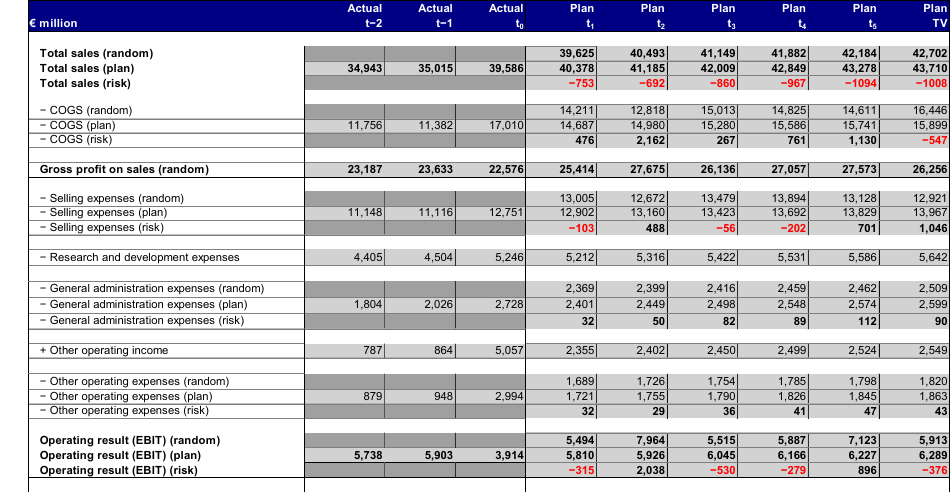
Figure 3. Excerpt of the income statement planning. In step 3, the insolvency risk is linked to the planning model and the insolvency probability is calculated via a heuristic function using the equity ratio and the return on equity employed (ROCE) (see Figure 4). The cells with the yellow background colour are output cells of the Monte Carlo simulation.